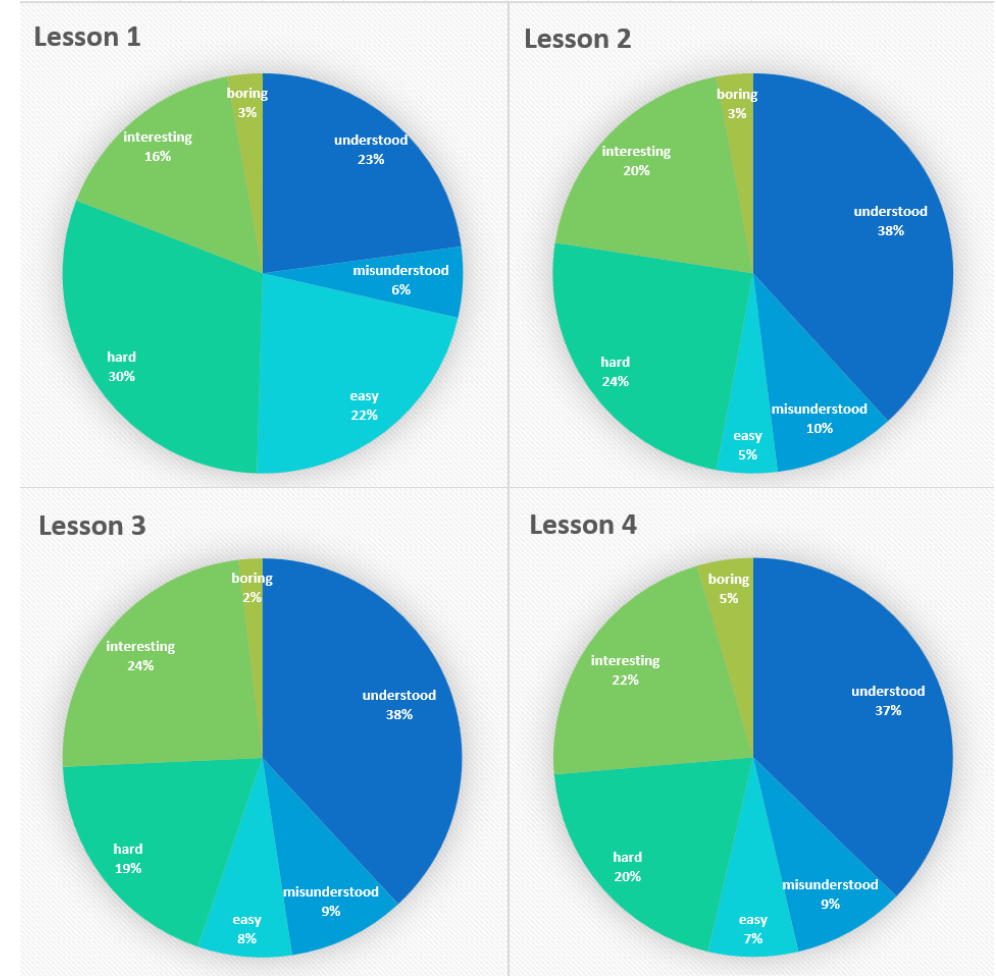
Figure 9. Frequency of customised emotions detection in each